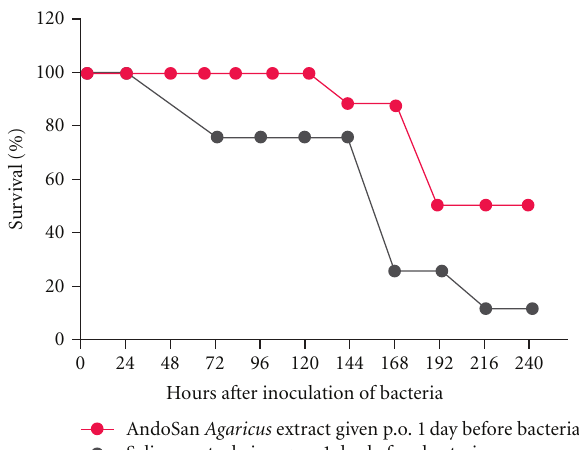
Figure 2: 5-6-week-old female inbred NIH/Ola mice were given either 200 μ L of AndoSan AbM extract or phosphate-bu ff ered saline (PBS) intragastrically a day before i.p. injection of 1 million colony- forming units of Streptococcus pneumoniae serotype 6B. There was a significant di ff erence ( P < 0 . 05) between survival after treatment with AndoSan (red line) and PBS (black line). From [14], permis- sion granted for republication by Scand J Immunol, where the figure was originally published.